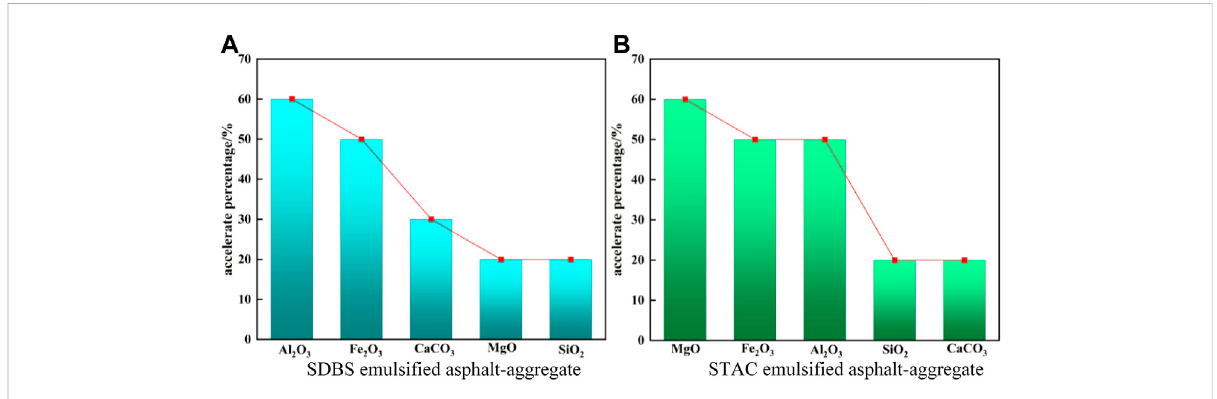
FIGURE 17 Acceleration effect of demulsi fi cation of the different aggregates over that of asphalt without any aggregates. (A) SDBS emulsi fi ed asphalt. (B) STAC emulsi fi ed